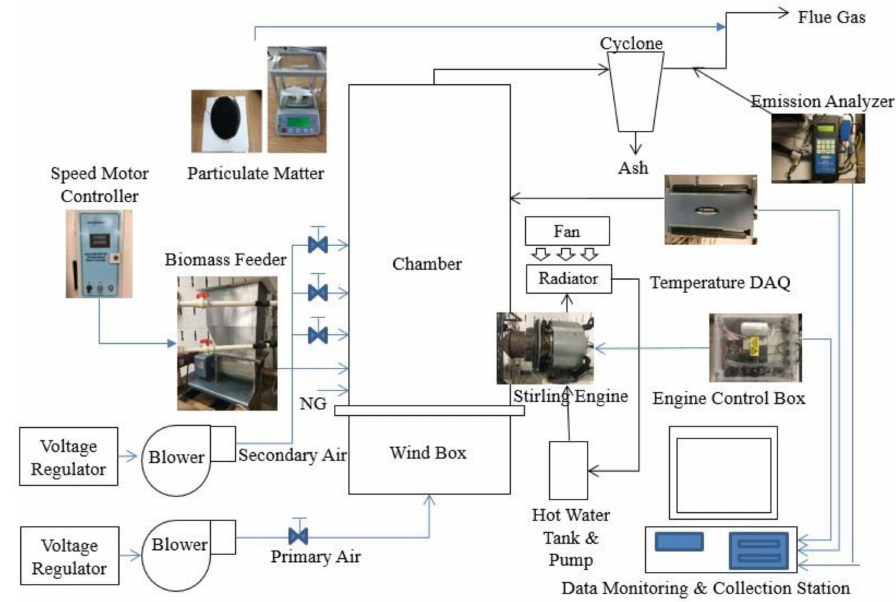
Figure 1. Schematics of the biomass conversion system and